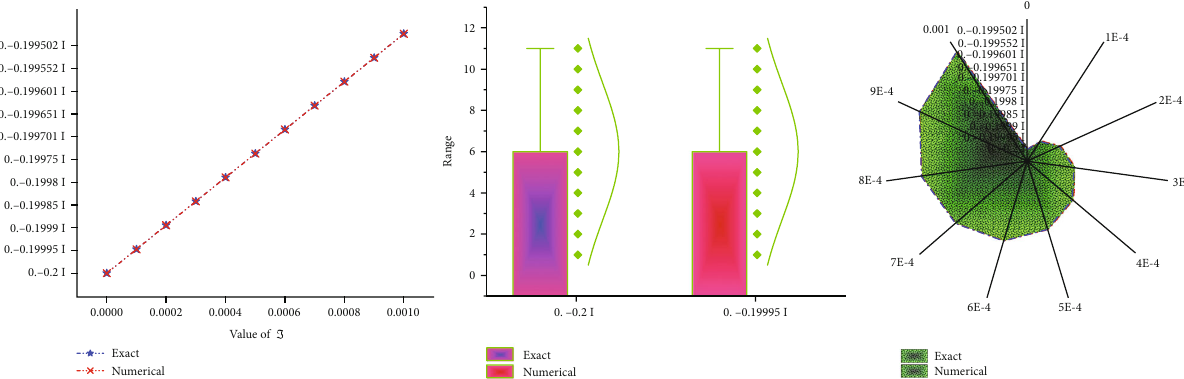
Figure 2: Exact and numerical solutions based on the obtained analytical solution Equation (19) and septic B-spline scheme.